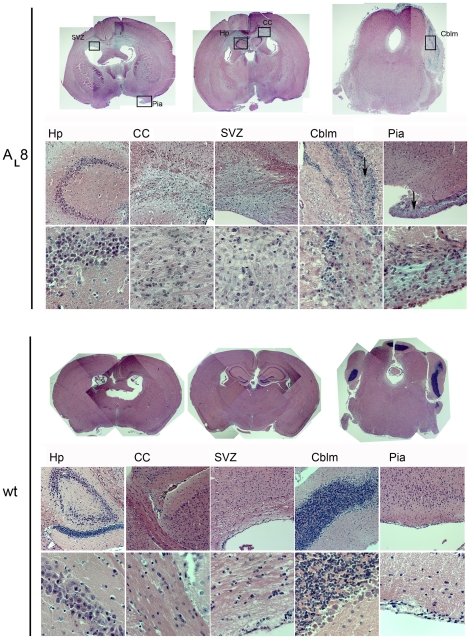
Increased cellularity in PDGF-AL brains.An overview of coronal sections of a PDGF-AL transgenic mouse brain (AL8 line, #4012) and wt littermate control (H&E staining). Higher magnification images in lower panels of selected areas from the overviews serve to illustrate areas of increased cellularity (20x and 40x objectives, respectively). A rather loose texture of the accumulating “clear” cells is indicated with arrows in pia and cerebellum. Strikingly, the borders of the inner granular layer in cerebellum appeared to be diffuse compared to wt control brain. Abbreviations: Hp-hippocampus, CC-Corpus callosum, SVZ- subventricular zone, Cblm – cerebellum.